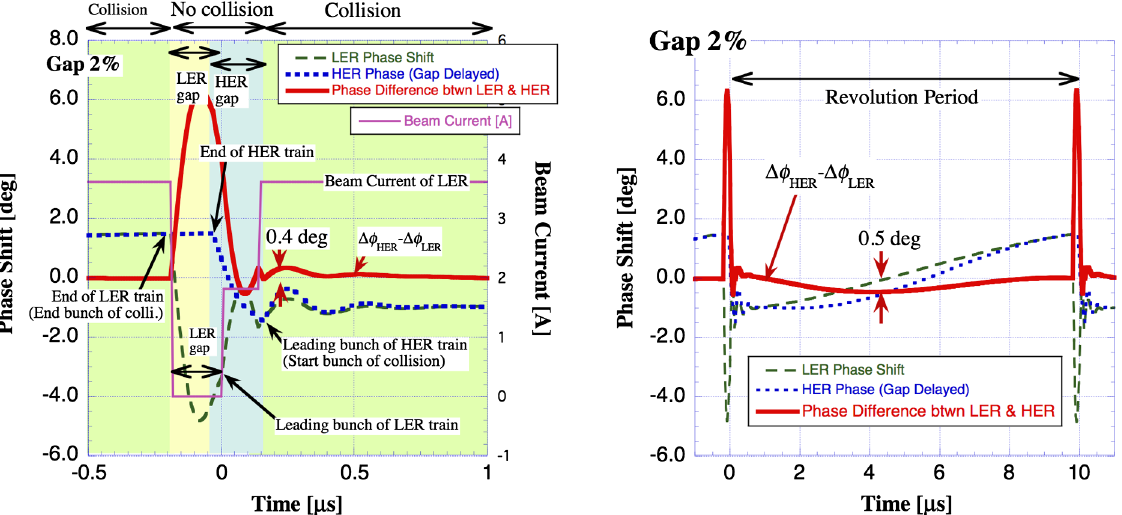
FIG. 16. Simulation result of phase difference for the best case of the fill pattern shown in Fig. 15. The gap length of both rings is 2% (200 ns), the current height at the initial step of the LER leading part ( b is 140 ns and the delay of the HER gap ( d